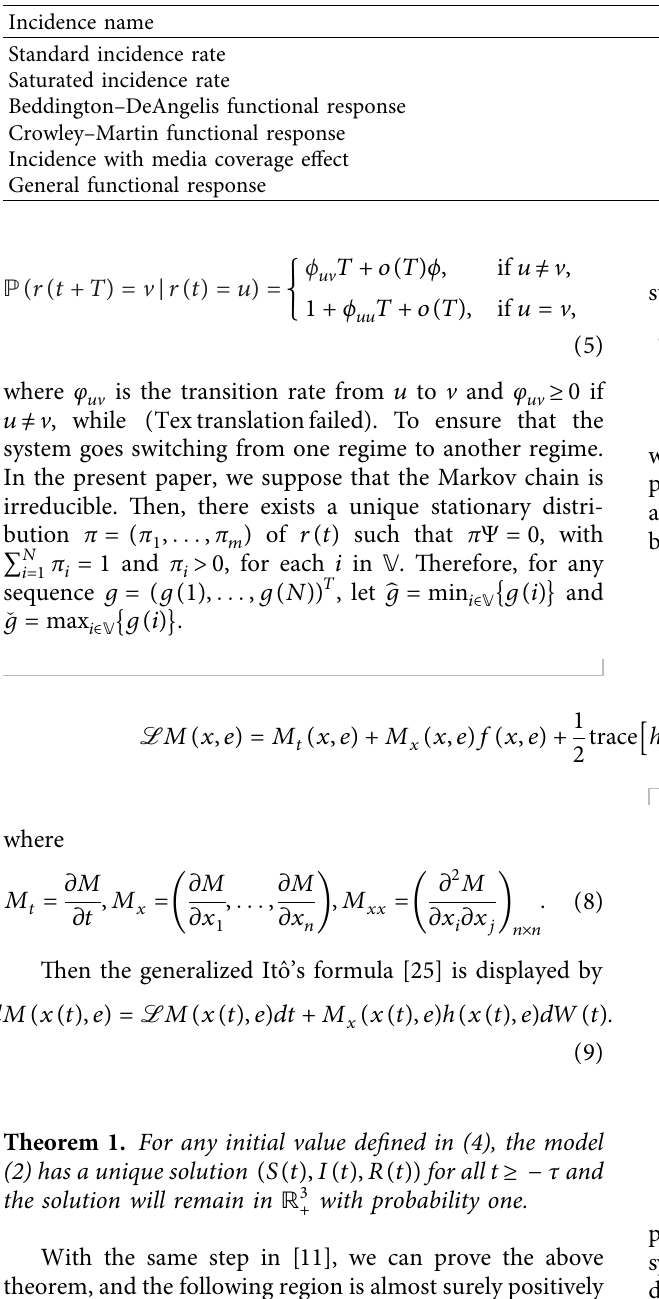
Table 1: Some nonlinear incidence